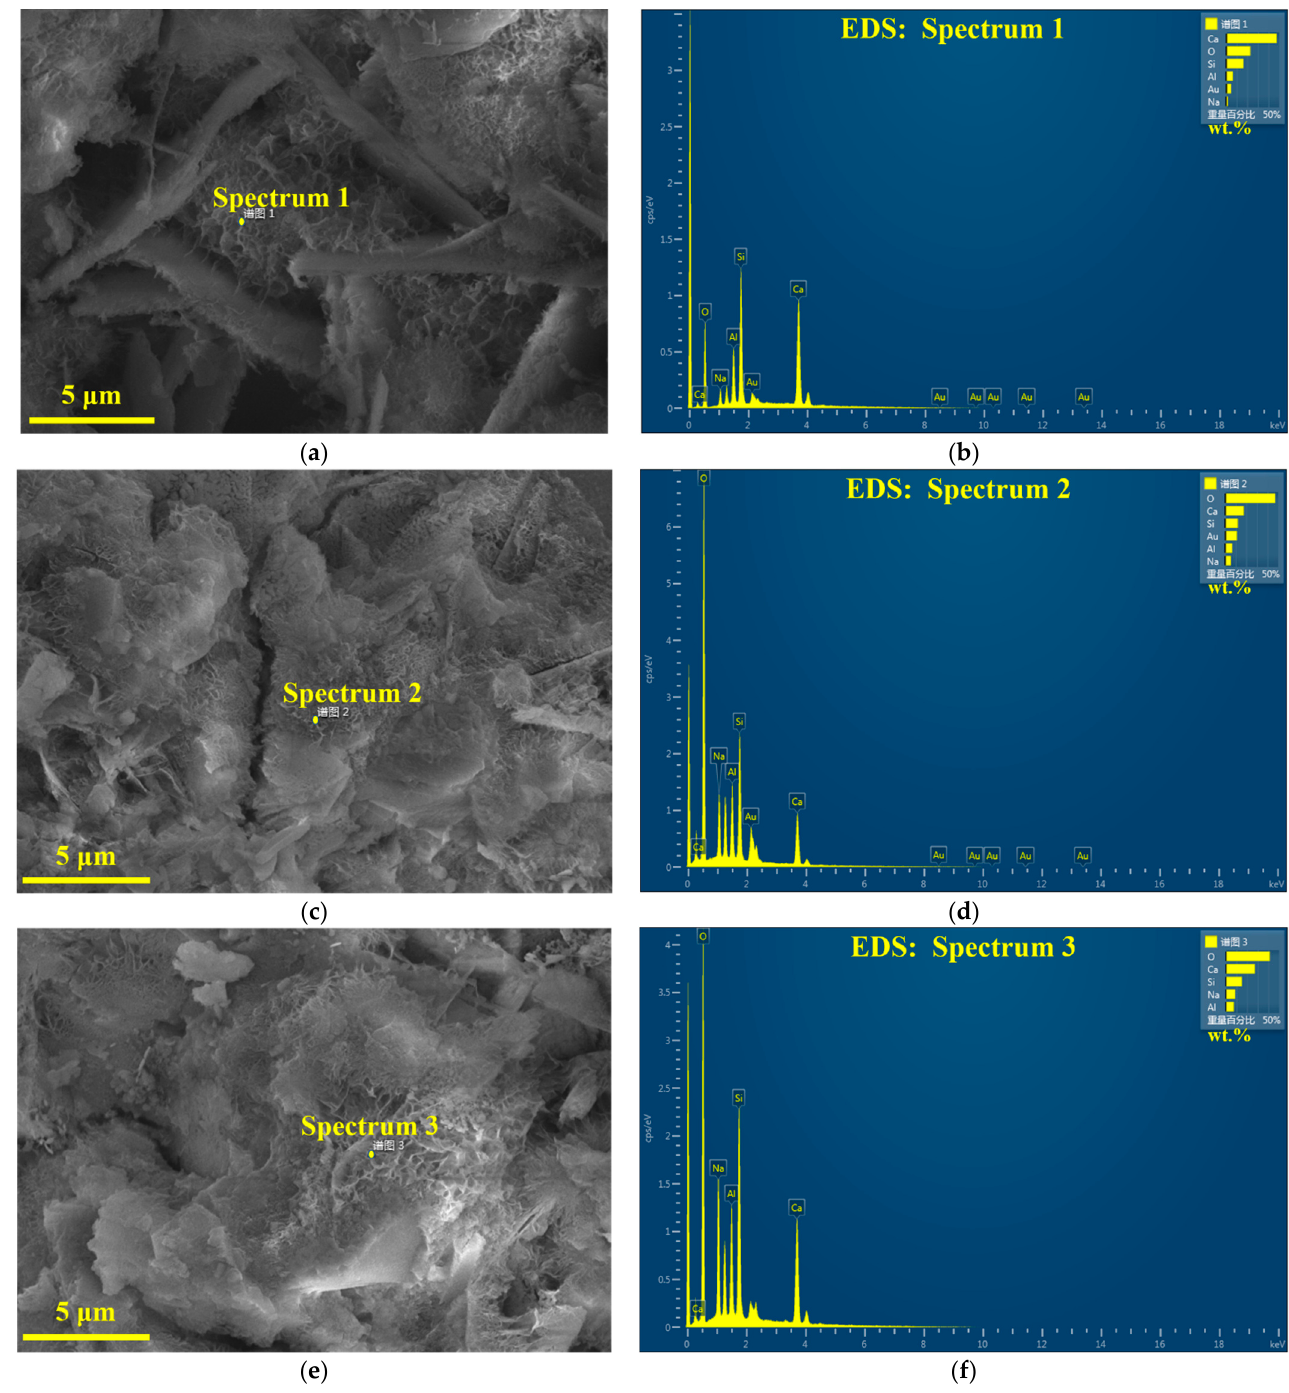
Figure 15. EDS test of the cement paste at 3 days: ( a ) Spectrum 1 of group S for EDS test; ( b ) EDS test result of spectrum 1; ( c ) Spectrum 2 of group FG-5 for EDS test; ( d ) EDS test result of spectrum 2; ( e ) Spectrum 3 of group FGDG-6 for EDS test; ( f ) EDS test result of spectrum 3.